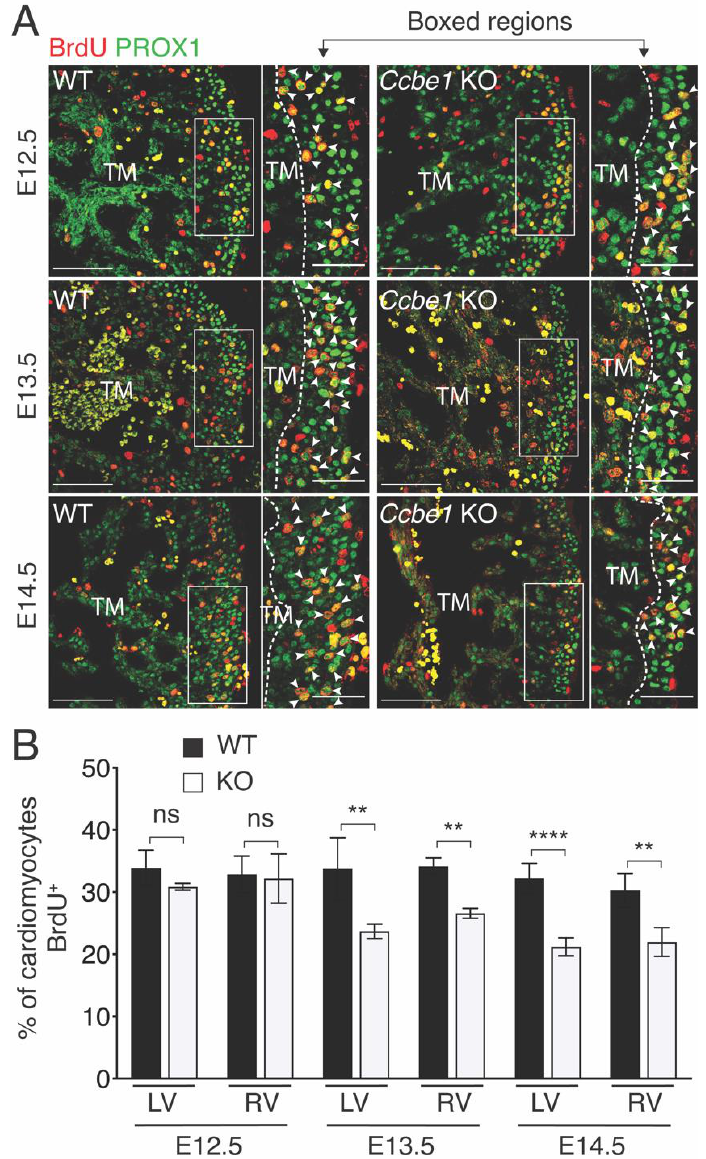
Figure 2. Ccbe1 tm1Lex mice demonstrate less cardiomyocyte proliferation. ( A ) Tissue sections through E12.5, E13.5 and E14.5 wild-type and Ccbe1 mutant hearts treated with BrdU and immunostained for BrdU and PROX1 to reveal proliferating cardiomyocytes. Arrowheads indicate BrdU + cardiomyocytes. Images are representative of the following number of replicates: wild-type, n = 4; mutant, n = 4 at E12.5; wild-type, n = 5; mutant, n = 5 at E13.5; wild-type, n = 5; mutant, n = 5 at E14.5. ( B ) Quantification showed that cardiomyocyte proliferation in compact myocardium is reduced in Ccbe1 mutant hearts at E.13.5 and E14.5. Dashed lines in ( A ) delimitate compact from trabecular myocardium. ns, nonsignificant; ** p < 0.01; **** p < 0.0001. Differences were considered statistically significant when p < 0.05. Error bars represent SDs. Scale bars = 100 μm. RV, right ventricle; LV, left ventricle; TM, trabecular myocardium.